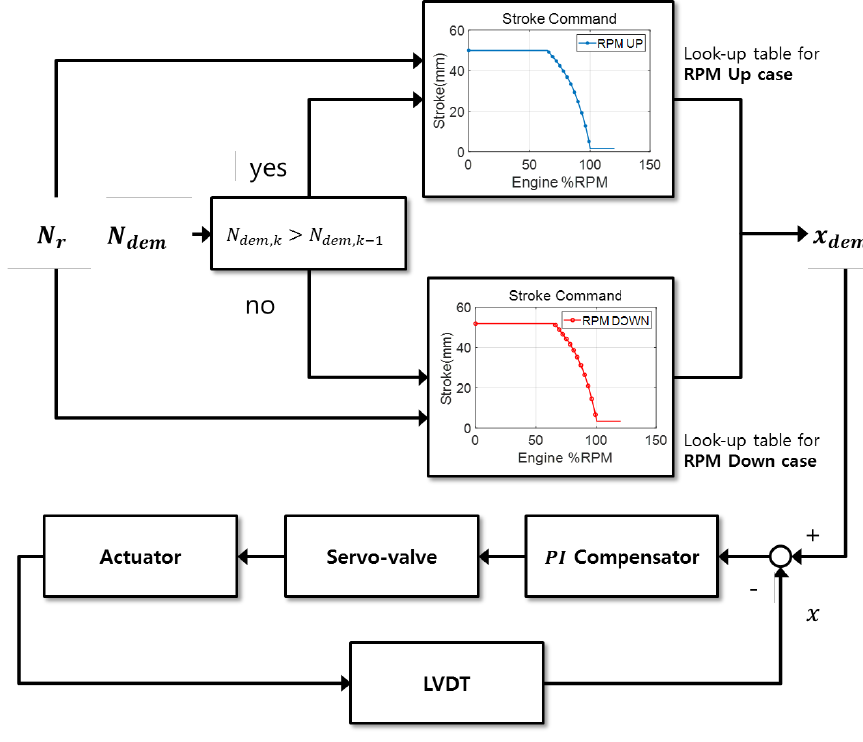
Figure 7. VGV link mechanism control diagram.